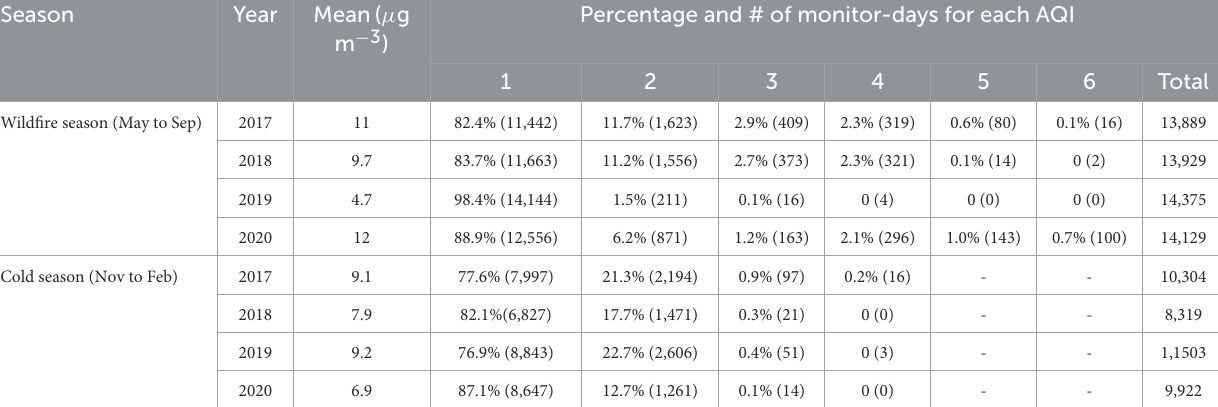
TABLE 4 Summary of the daily PM2.5 observations from two seasons in 2017 to 2020 at AQS sites in the PNW region. Note that daily AQI is computed using PM2.5